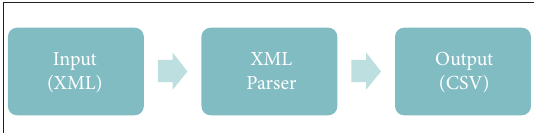
Figure 6: Parsing an XML to